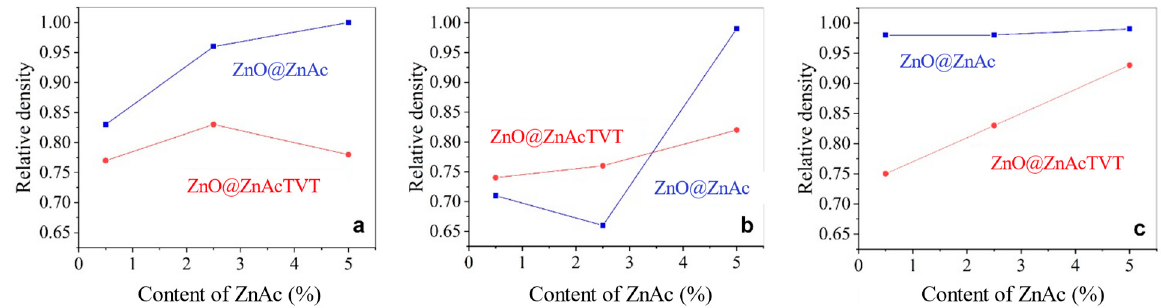
Figure 11. Relative density of ceramics vs. ZnAc concentration for different types of die sealing in CSP: single copper sealing, 1C ( a ); double copper sealing, 2C ( b ); double PTFE sealing, 2P ( c ).